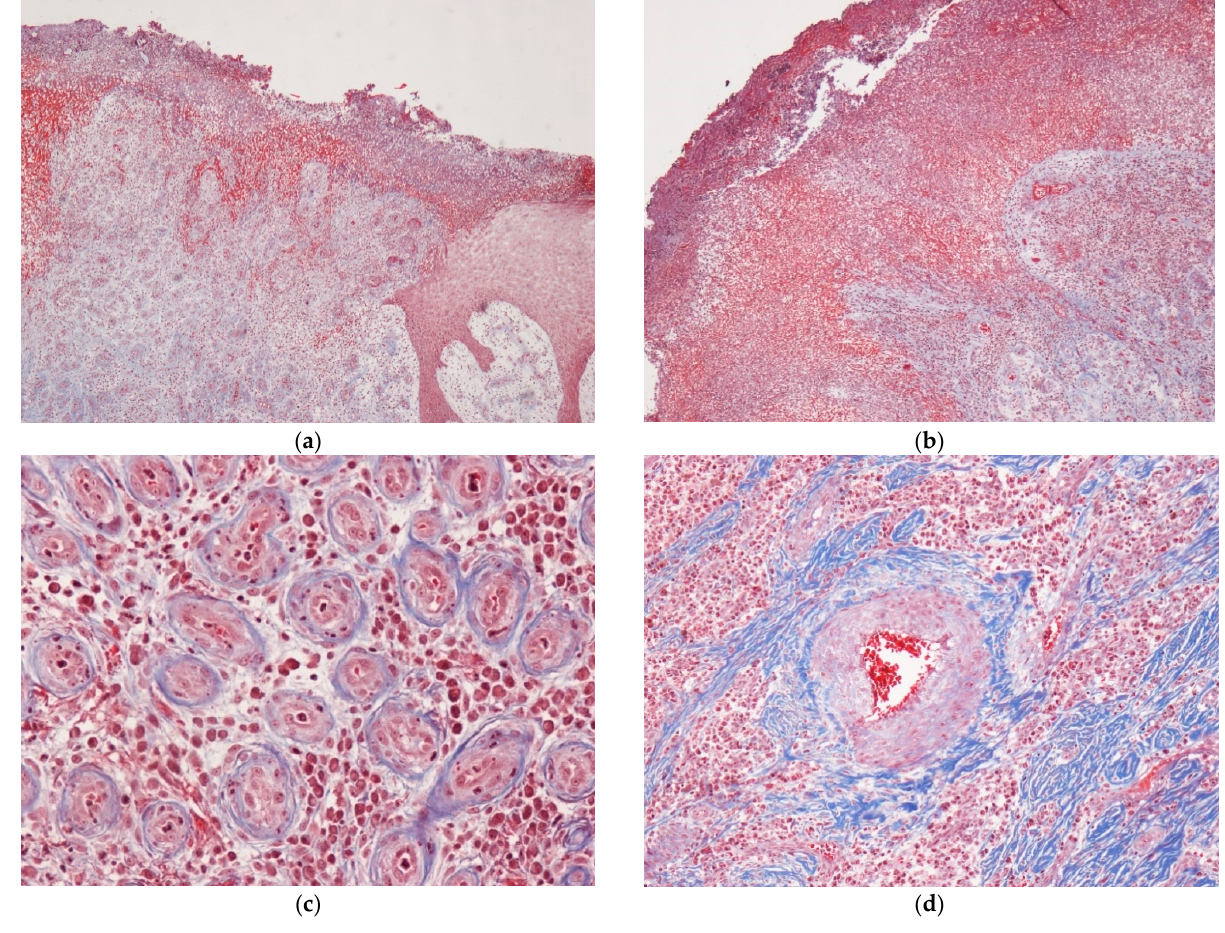
Figure 2. Histopathological panoramic features of lobular capillary hemangioma at low magnification. Fibrous septa and collarettes of the adnexal epithelium that partially surround the lesion ( a ). Lobular areas located beneath the ulcerative area covered with a layer of fibrin and entrapped neutrophils ( a , b ). Marked proliferation of blood vessels with wall thickening lined by flattened endothelial cells can be observed ( c ). Stroma with an area of abundant collagen fibers and mixed infiltrate of inflammatory cells around the central blood vessel can be observed ( d ).